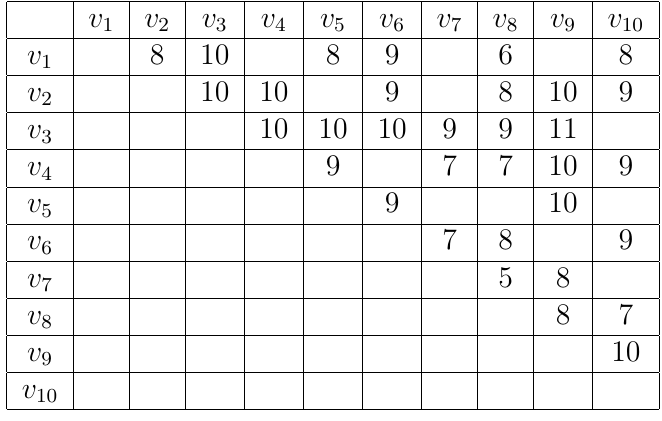
Table 3: Degree of edges of the